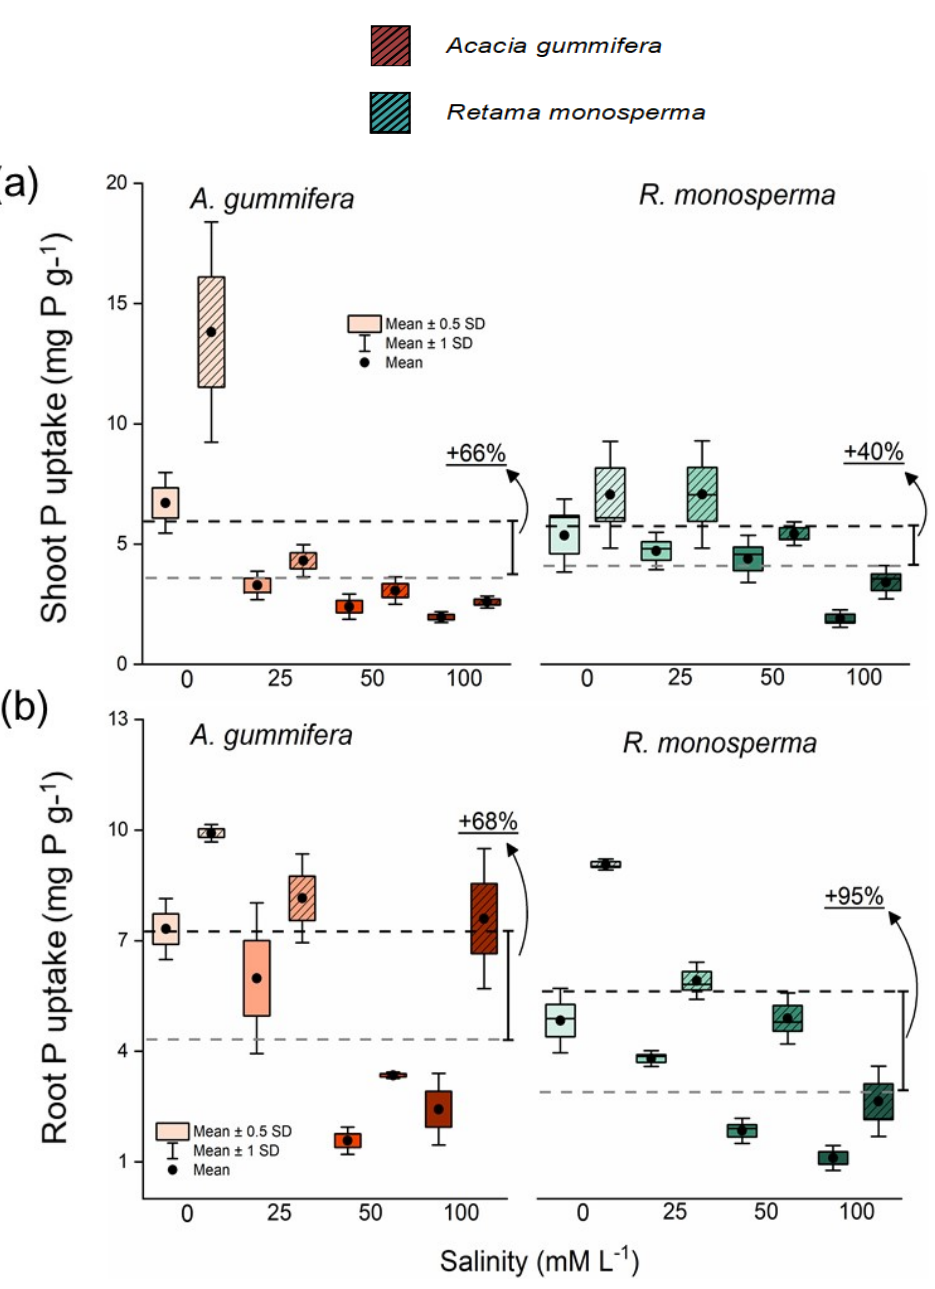
Figure 3. Boxplots of P uptake in the shoot ( a ) and root ( b ) of the non-inoculated and inoculated Acacia gummifera and Retama monosperma plants under different salinity levels (0, 25, 50 and 100 mM NaCl). The average values of mycorrhizal shoot and root P uptake response for A. gummifera and R. monosperma species are shown by the percentage of increased response. Mycorrhizal inoculated plants are represented by dashed boxplots for both A. gummifera and R. monosperma species. At the different salinity concentration, A. gummifera species are represented by antiwhite and brown colors, and R. monosperma species are shown by tea-green, and green colors, respectively.